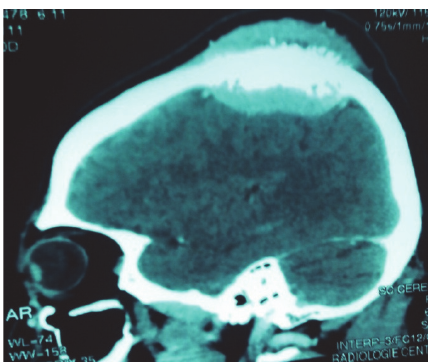
Figure 1: CT of the brain at presentation showing osteoblastic mass on the skull.